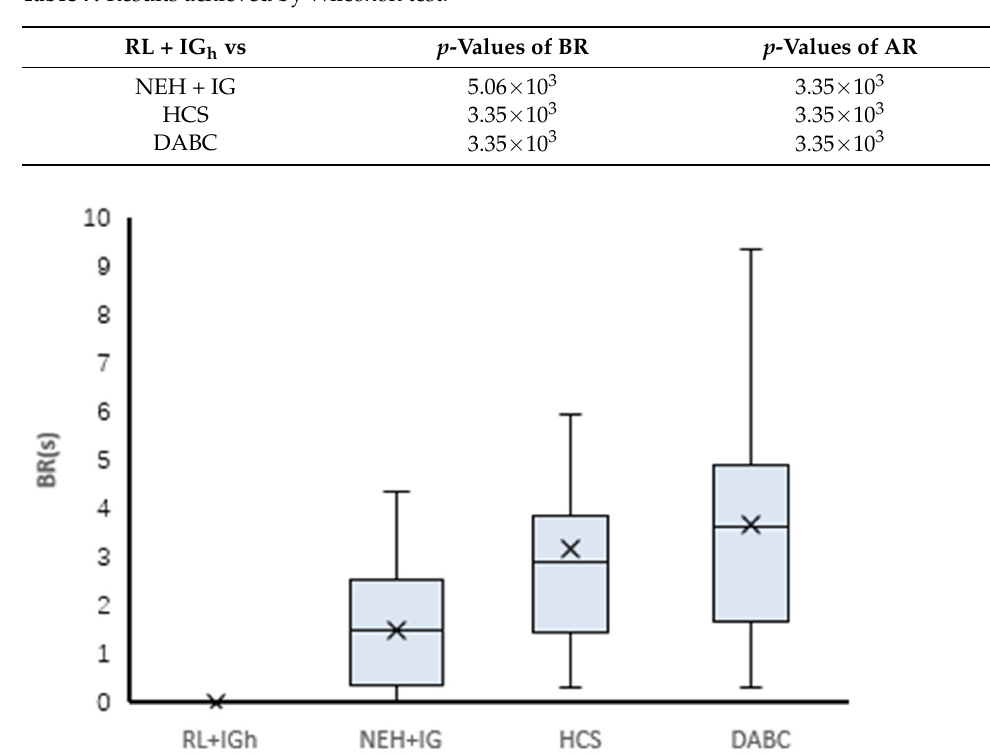
Figure 11. Box plot of RL + IG h and other meta-heuristic algorithms. The method is also compared with the original PtrNet [24,47] and there is no GIN graph encoding module in the structure. Before the job feature vector x i is input into the network, the proposed method will expand the dimension through a simple linear transformation layer, and the PtrNet uses a simple graph embedding of node aggregation. The major difference between the two methods is that the encoder and decoder of the